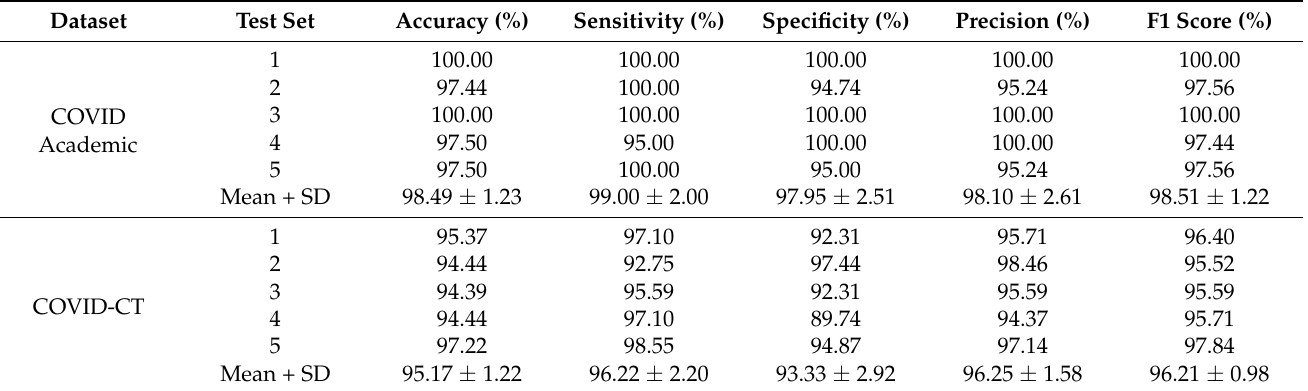
Table 6. Test performance based on